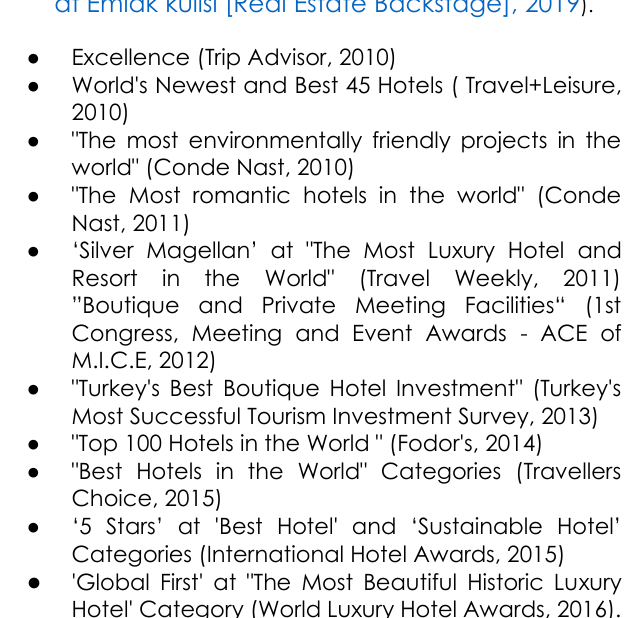
Table 3. Global and National Awards of Argos ( Developed by Authors based on